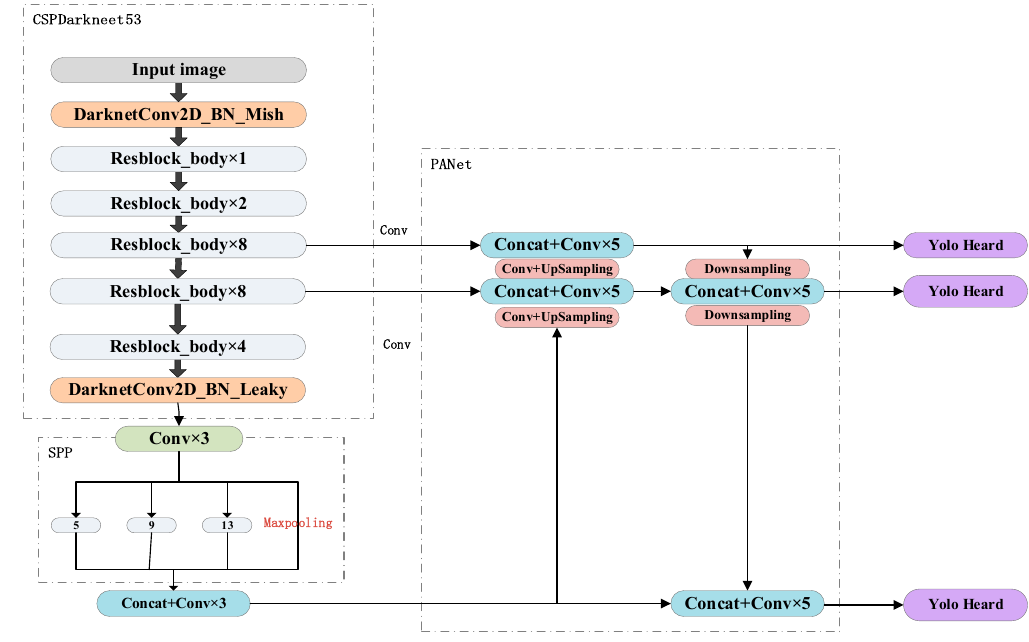
Figure 1. You Only Look Once version 4 (YOLO-V4) network architecture.